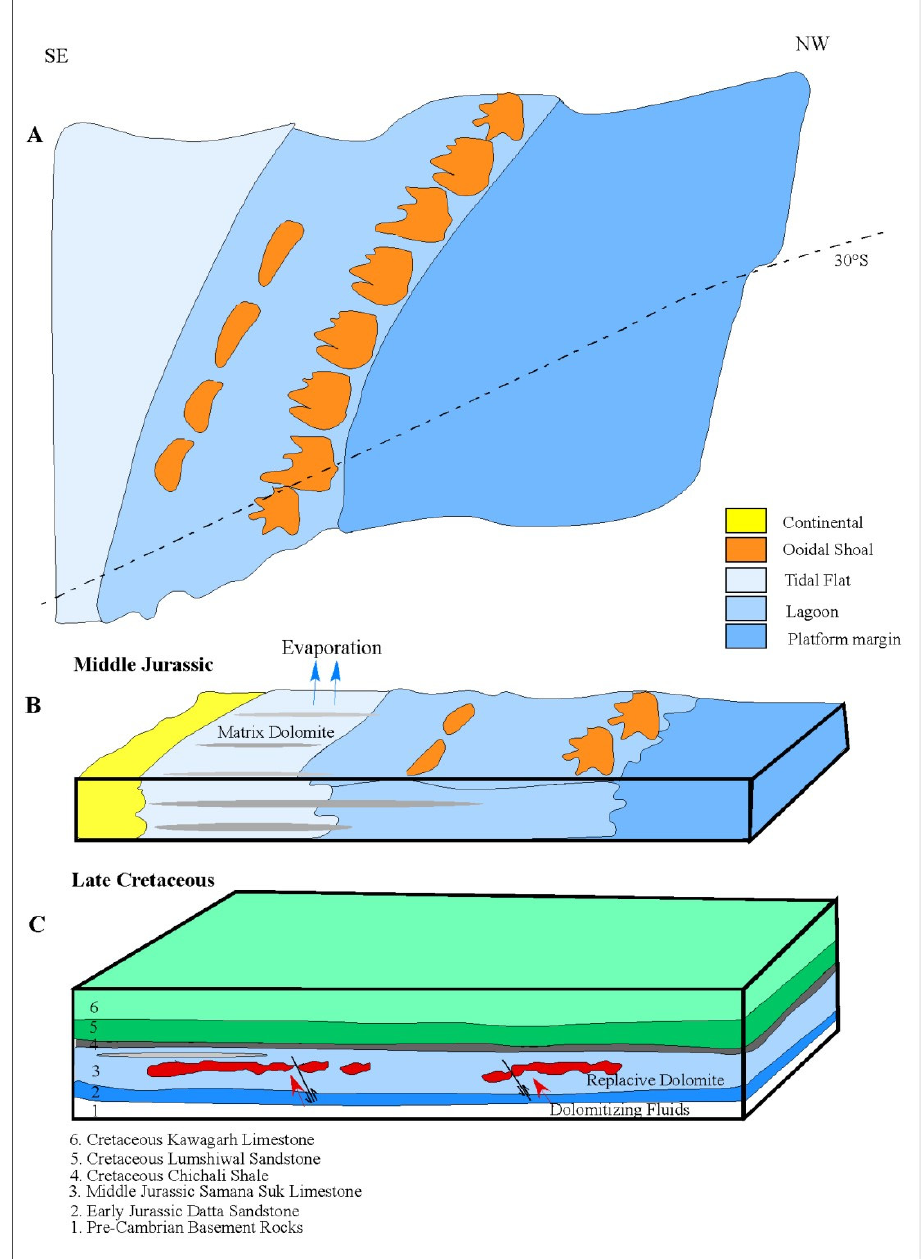
Figure 13. Model of multiphase dolomitization in the Samana Suk Formation ( A ). Paleogeographic reconstruction of the middle Jurassic of the northern margin of the Indian plate after Hussain, Fayaz, Haneef, Hanif, Jan, and Gul [31]. ( B ) A block diagram showing the formation of matrix dolomites. ( C ) The block diagram shows the formation of replacive and saddle dolomite channeled through fractures and faults.